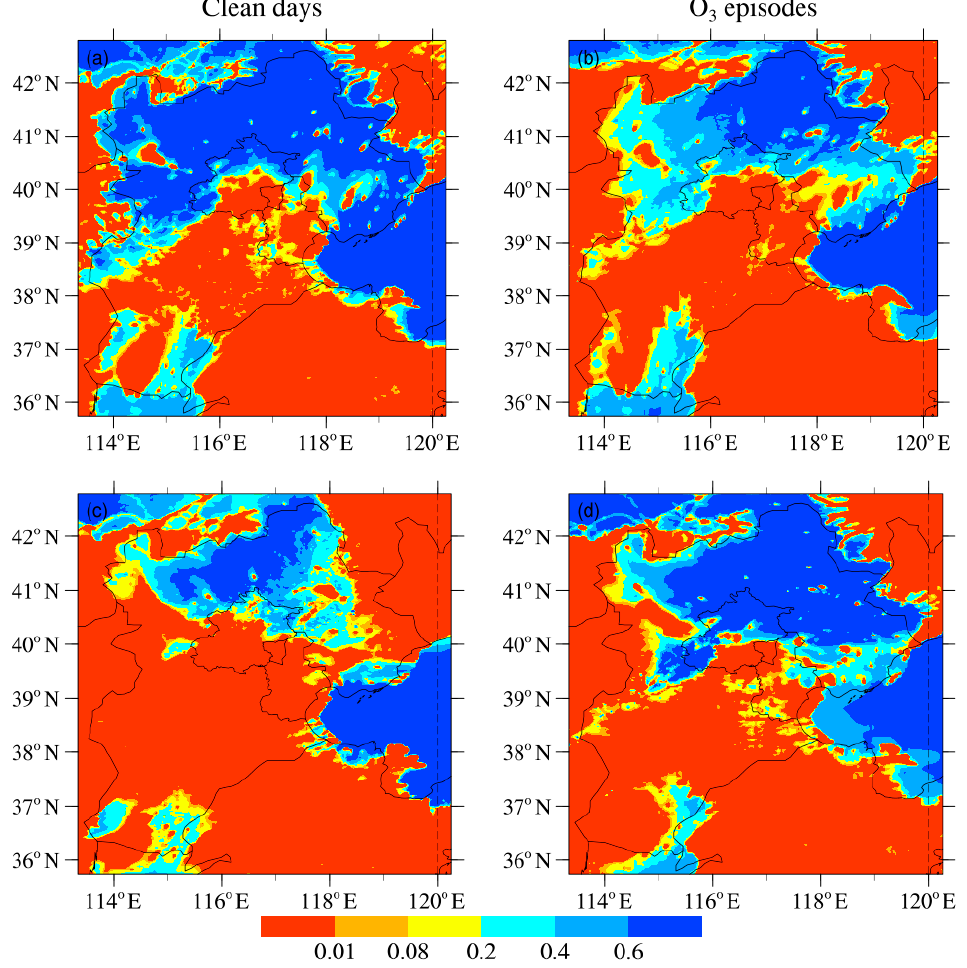
Figure 11. The distribution of the ratio of P(H 2 O 2 ) / P(HNO 3 ) in July and August 2017 over the NCP ( a – d ); ( a , c ) represent clean days (O 3 < 100 µ g / m 3 ), ( b , d ) represent O 3 episodes (O 3 > 200 µ g / m 3 ), and the rows from top to bottom represent July and August.